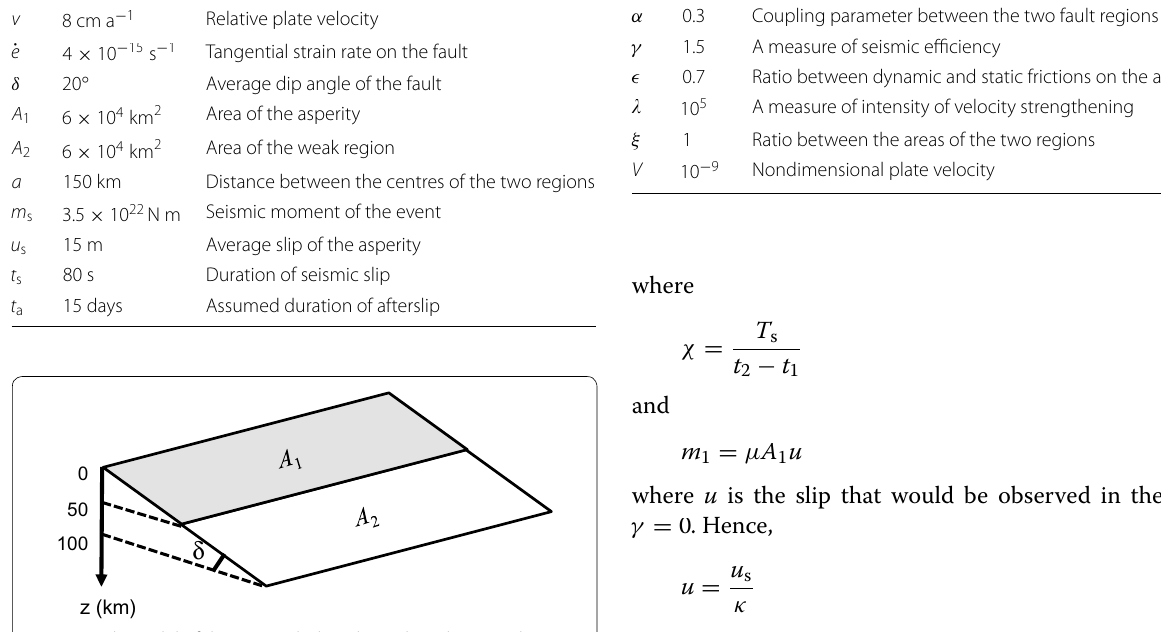
Fig. 7 Fault model of the 2011 Tohoku-Oki earthquake. A 1 and A 2 are the areas of the asperity and of the weak region, respectively, and z is depth. The model is a simplified version of the tectonic settings sug- gested by Lay et al. (2012) and Silverii et al. (2014)